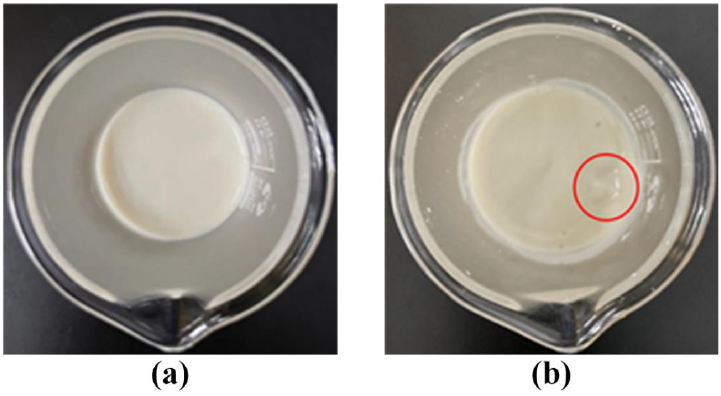
Figure 5. LMP-Bt colloid: ( a ) before absorbing gas products and ( b ) after absorbing gas products.